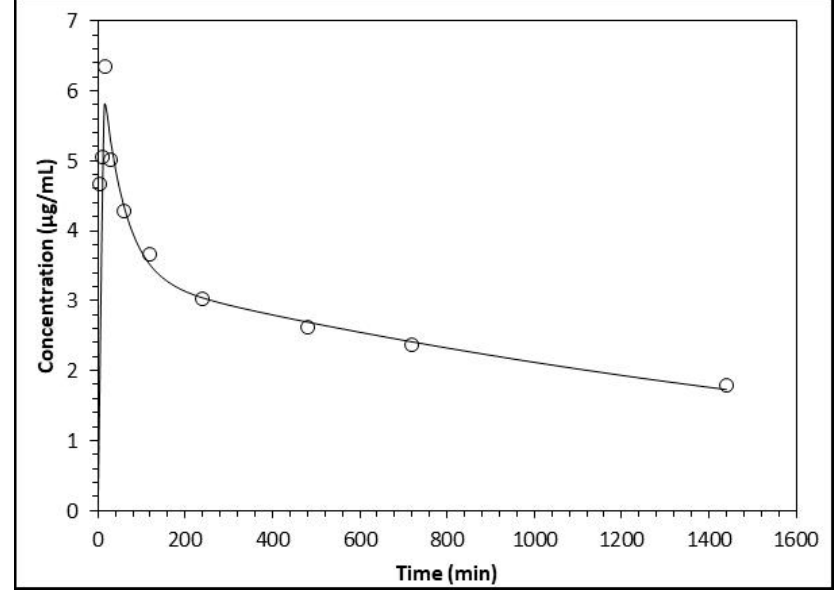
Figure 3. Analysis of the variation of plasma concentration of m -HPAA (open circles) with respect to the time in minutes. The line represents the prediction of the behavior of the concentration following a two-compartment model.